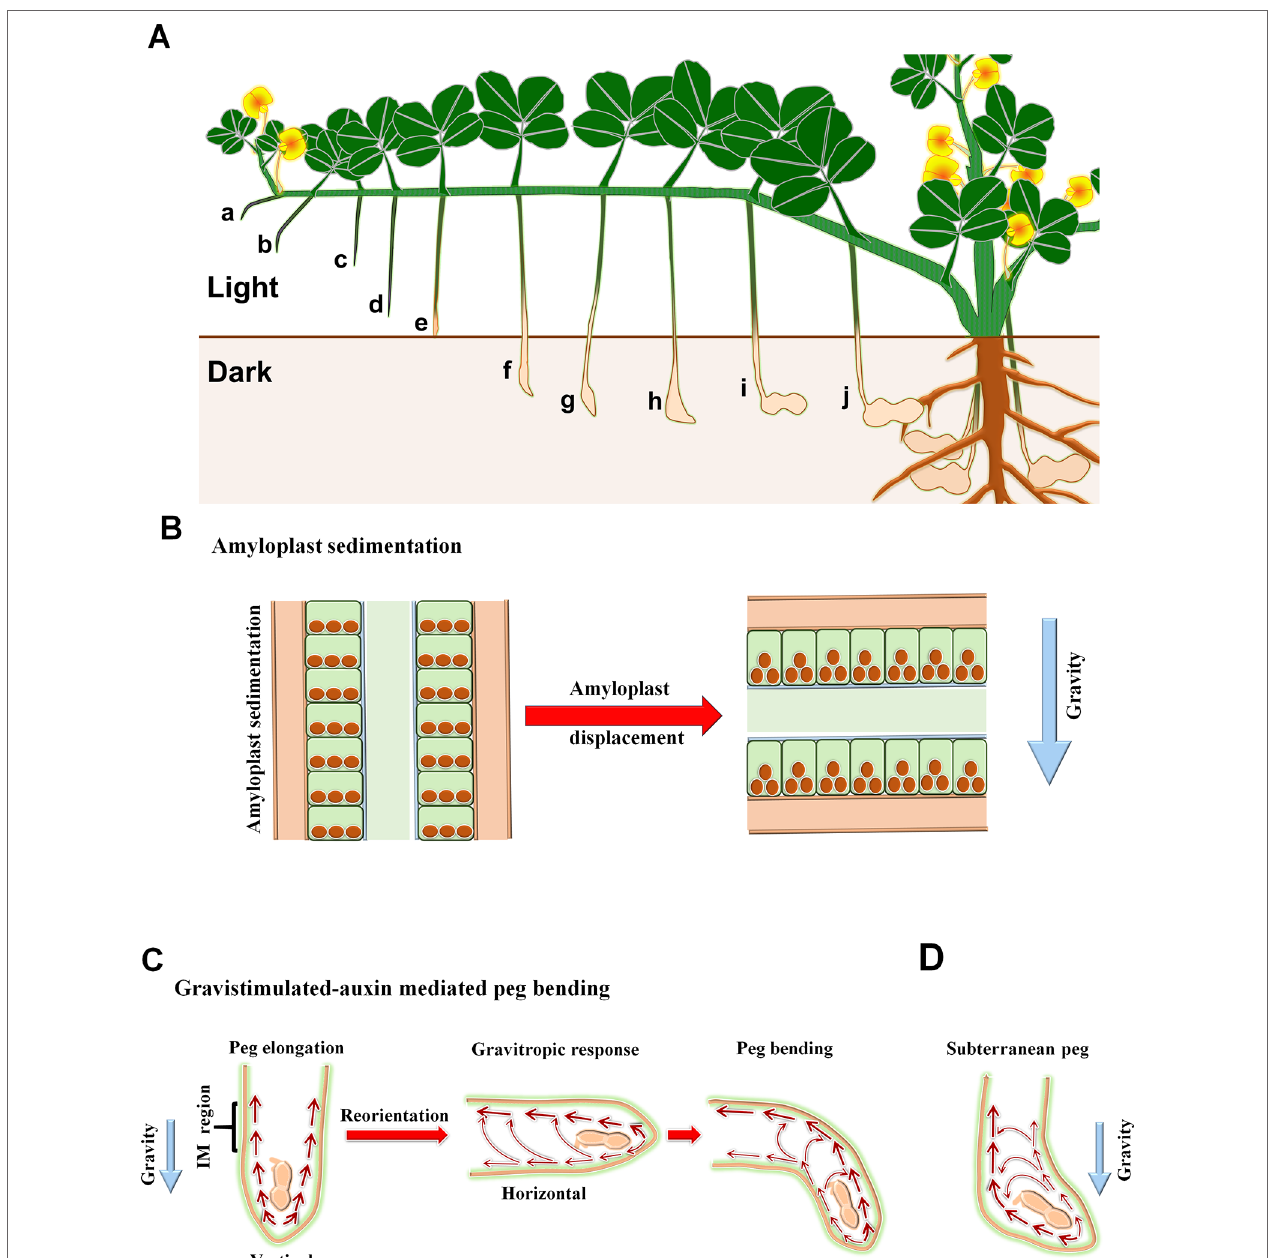
FIGURE 2 | Representation of morphological and physiological changes associated with peg development and pod initiation. (A) Pictorial representation of pegging. a–b, gravitropic response; c–d, peg elongation; e, peg touching soil which impact mechanical stimulus; f–h, peg tip reorientation against gravity; i–j, pod swelling and seed setting; (B) Sedimentation and displacement of amyloplast during peg elongation (vertical position, left panel) and gravity induced bending (horizontal position, right panel); (C) Distribution of auxin in peg during elongation and gravitropic bending, and (D) agravitropic bending of subterranean peg. Thickness of arrow indicates the abundance of